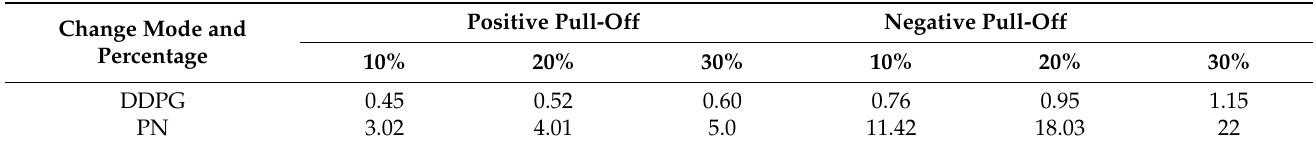
Table 6. Statistics of miss distance with changing aerodynamic parameters.